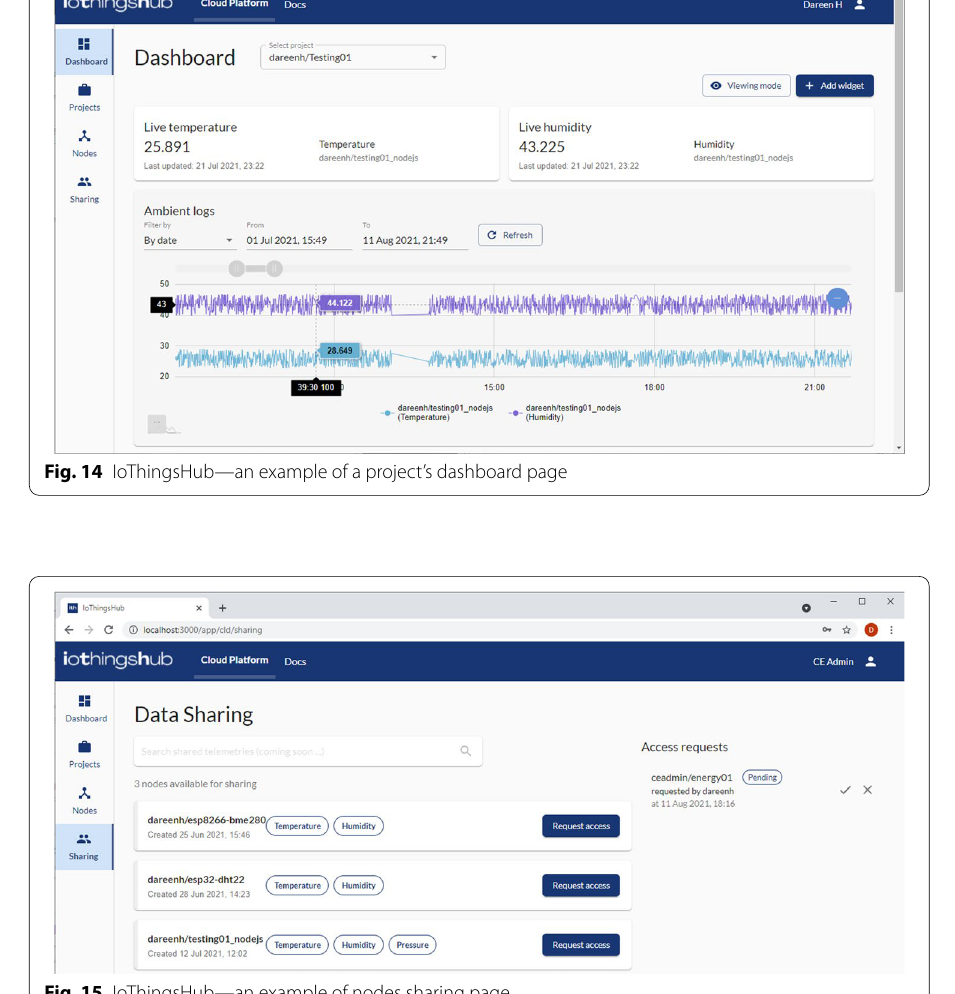
4. Widget . A typical IoT widget for displaying nodes data in various forms. Users may